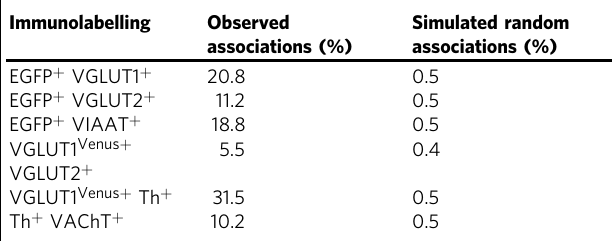
Table 1 Observed versus simulated random associations of immunolabeled